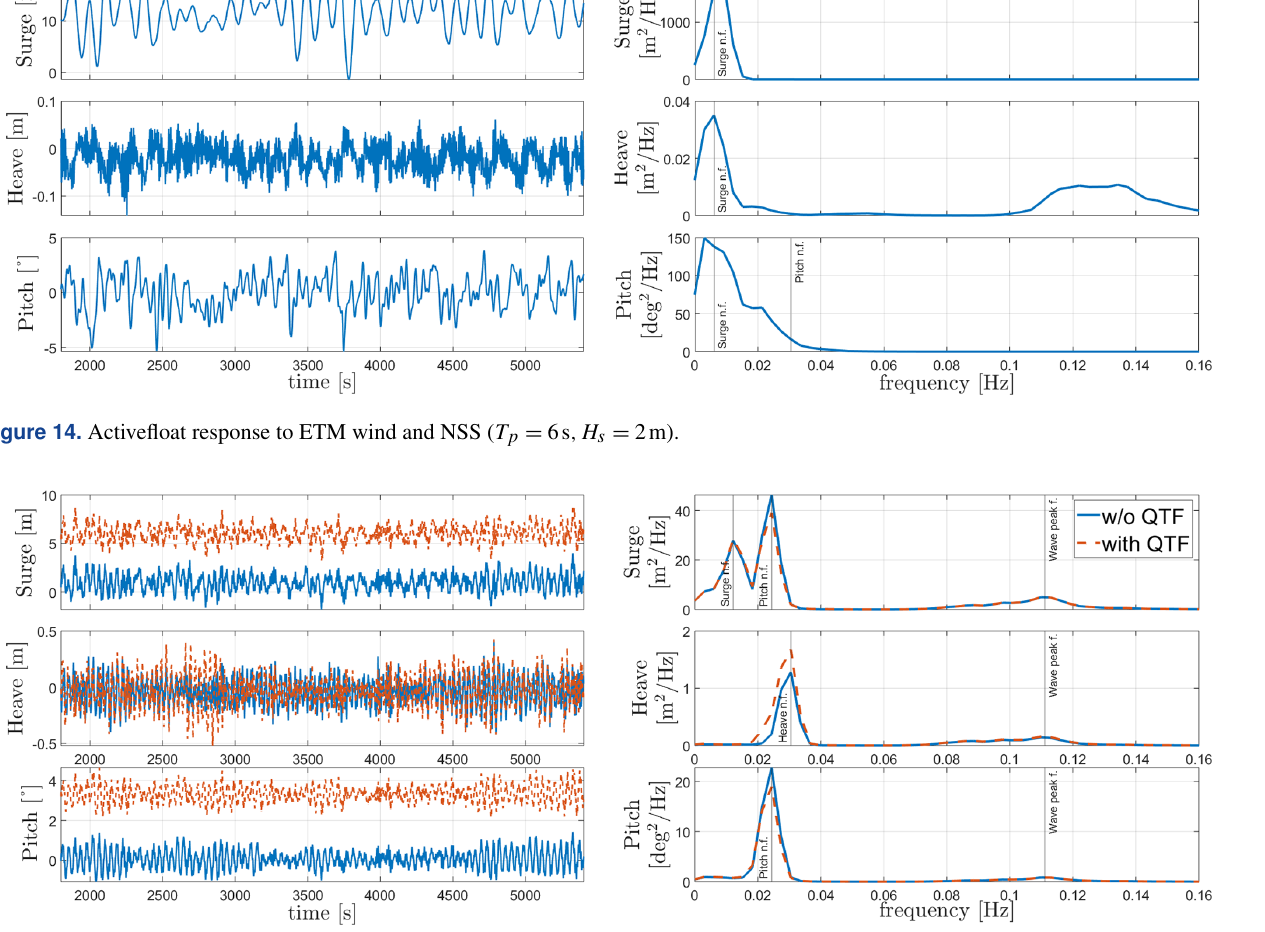
Figure 15. WindCrete response to EWM for 50 years of wind and ESS ( T p = 9s ,H s = 5 . 11m).